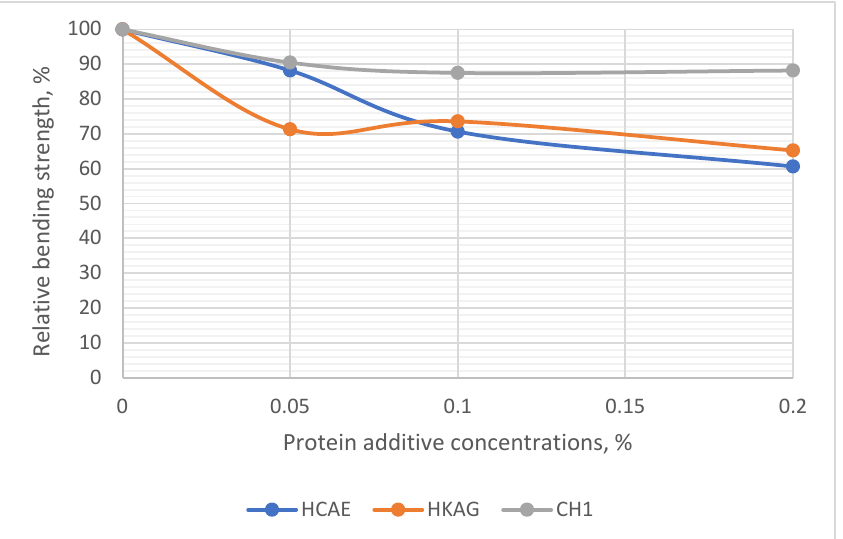
Figure 11. Relative bending strength of plasters with different concentrations of protein additives.